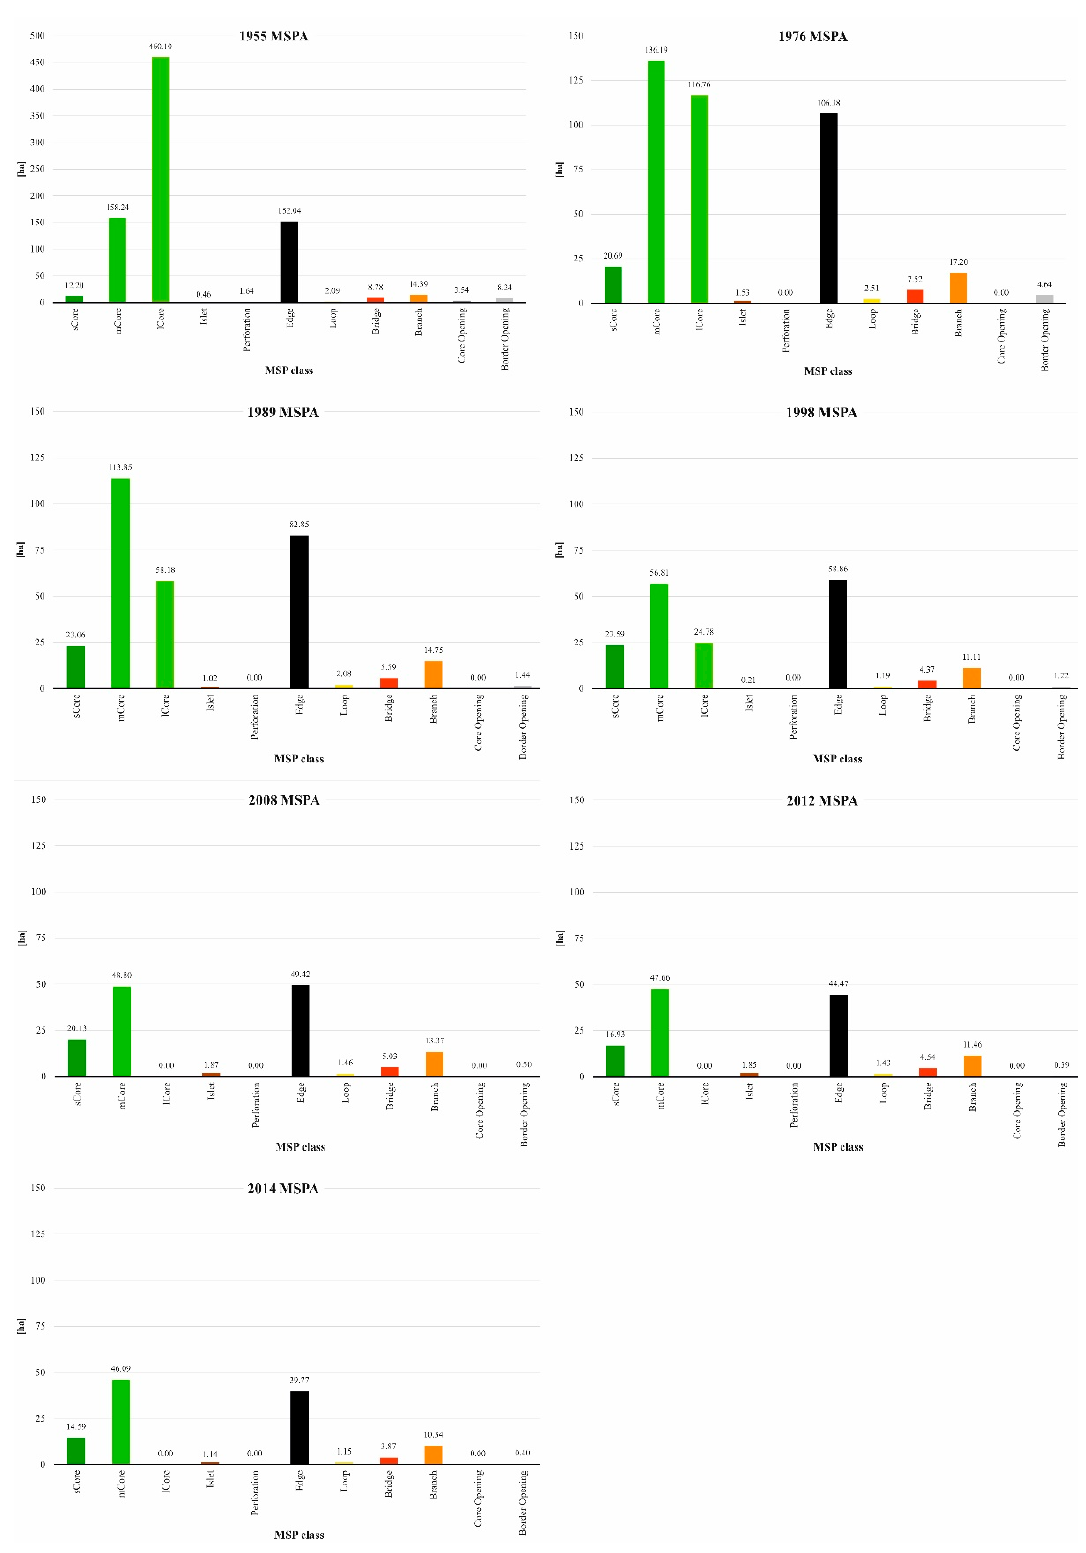
Figure A1. Morphological spatial pattern analysis (MSPA) results in terms of the surface occupied by each class in each investigated year.